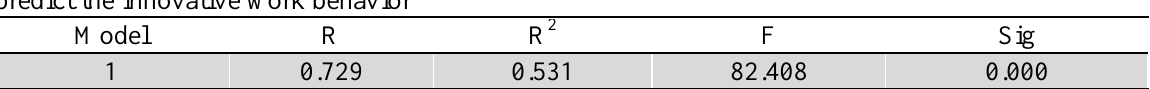
Regression analysis of multi variables on the predictor components of emotional intelligence to predict the innovative work behavior Model